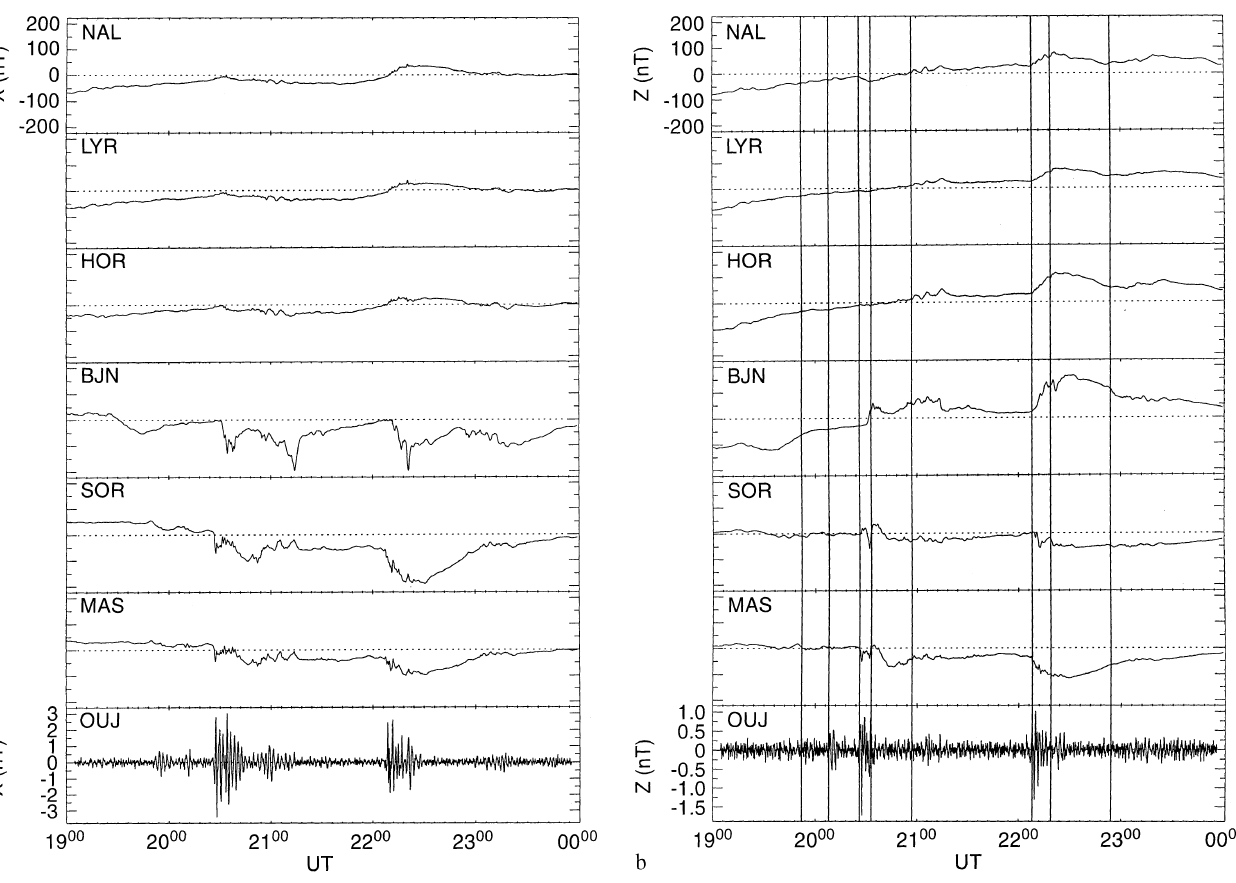
displayed.Abandpassfiltered(200–20s)tracefromOUJ,highlighting Pi2 pulsation activity, is included in the bottom panel . Substorm expansion phase onset/intensifications are marked with